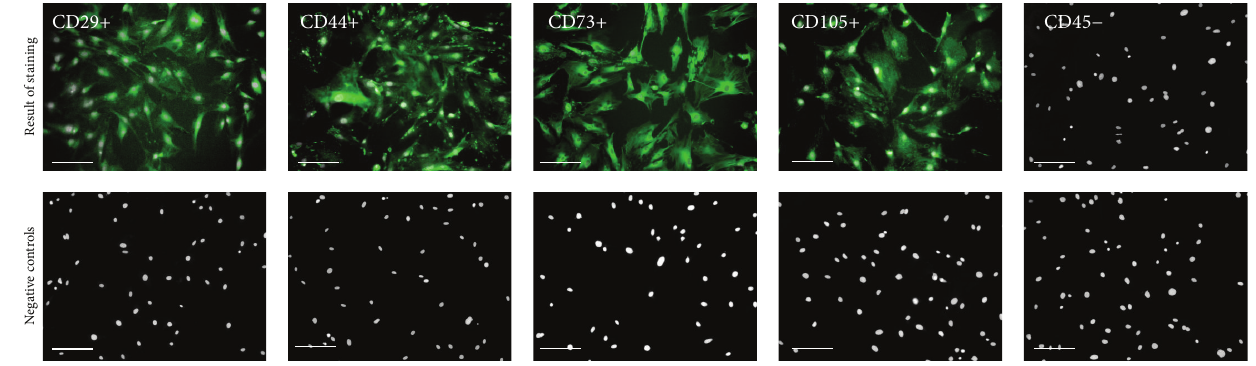
Figure 1: The results of mice adipose-derived mesenchymal stem cells immunophenotyping represented in images. Immunostaining analysis was performed on three ASCs cultures, after second passage. The obtained populations of cells were positive for markers characteristic for mesenchymal cells, that is, CD29, CD44, CD73, and CD105, and were negative for hematopoietic marker CD45. Particular markers were stained with specific primary antibody and secondary antibody conjugated with atto-488 (positive reactions shown in green), and nuclei stained with DAPI are shown in white. Results of negative staining are included in the Figure. Magnification used is 100x. Scale bar = 250 𝜇